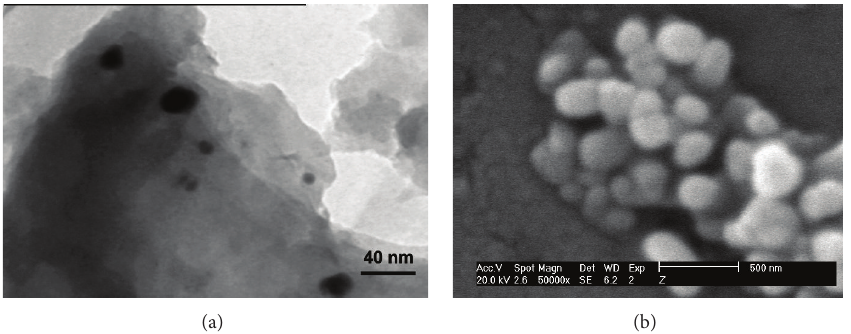
Figure 5: SEM (a) and TEM (b) images of biosynthesized AgNPs. Synthesis conditions: silver nitrate concentration, 1mM; temperature, 45 ∘ C, extract pH, 9; extract concentration, 40 g/L.